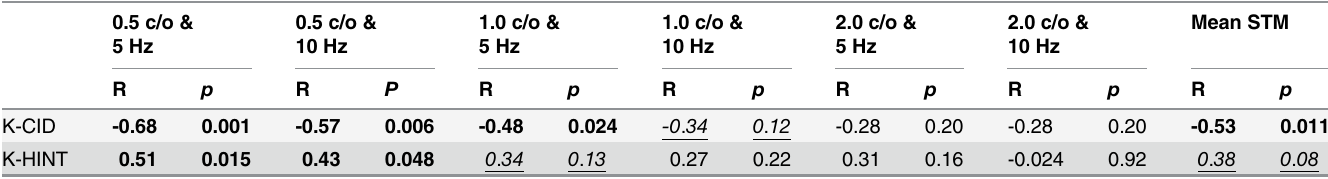
Table 5. Results for partial correlations analyses. Bold values indicate significant correlations at the level of 0.05. Underlined italics indicate the correla- tions that were originally significant shown in Table 4 but became non-significant after controlling for predictive effect of static-ripple detection. Partial correlations between STM detection test measures and sentence recognition in quiet (K-CID) and in noise (K-HINT) while controlling for predictive effect of static-ripple detection.